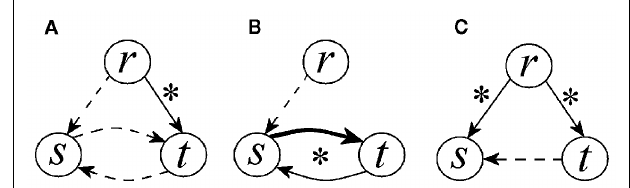
FIGURE 8 | Graphical representation of the results of causality analysis in the three considered conditions: supine position, spontaneous breathing (A), upright position, spontaneous breathing (B), and supine position, paced breathing (C). Arrows between two variability series ( r : respiration, s : systolic pressure; t : heart period) are present when the corresponding causal coupling index is non-zero in at least half of the subjects (i.e., the index C has a non-zero median).The style of the arrow is arranged so that to reflect the statistical significance of changes in the index C observed between conditions (i.e., the coupling is significantly stronger for solid arrows than for dashed arrows, and for bold arrows than for solid arrows). Further, the statistical significance between the two causal directions for a given condition (i.e., the significance of the directionality index D ) is marked with an